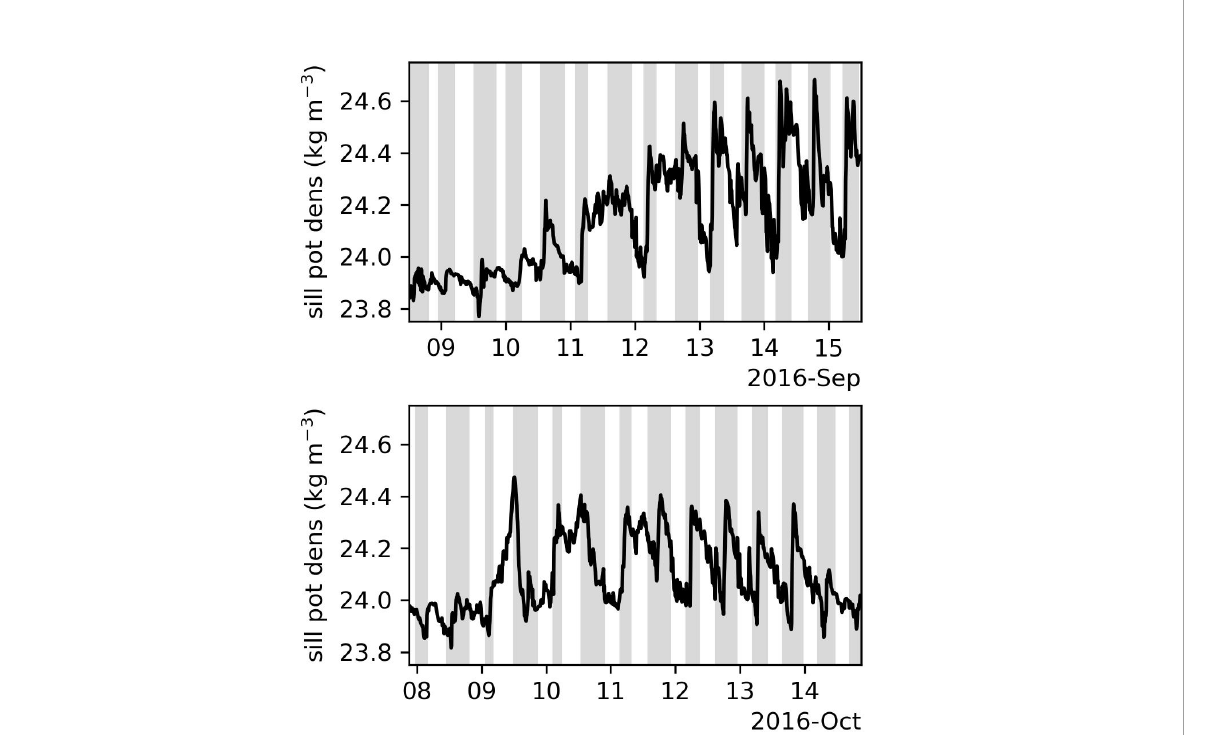
FIGURE 8 Potential density ( s q kg m -3 ) at the sill mooring, 10-min frequency data. Upper panel shows data from one week in September 2016 while lower panels shows one week in October 2016. Each time period begins two days before the minimum in smoothed tidal current speed predicted at Active Pass. Grey bars in background mark fl ood tide/white marks ebb